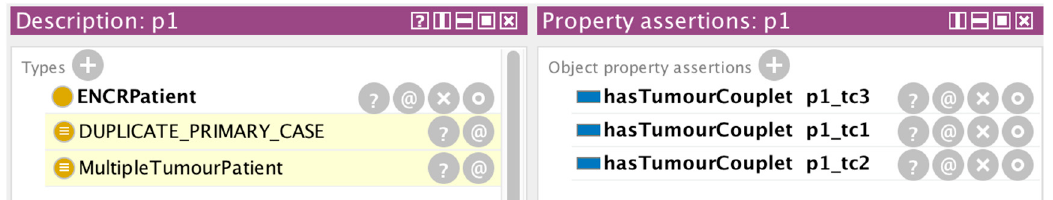
Figure 5. Results of the reasoning operation for the tumour couplet p1_tc3. Since the topography codes are equivalent and the morphology codes (of non-haematological type) are identical, the couplet is an invalid MPT and is classified as a duplicate primary tumour.